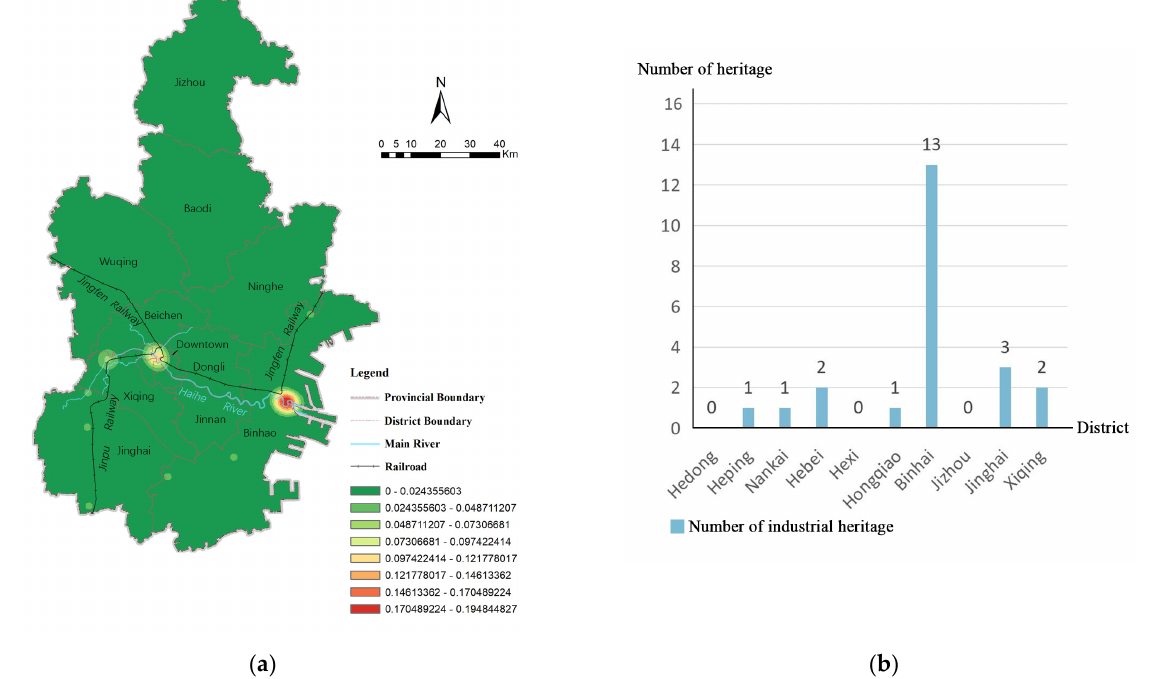
Figure 12. ( a ) Analysis of the kernel density of structure-type industrial heritage in Tianjin; ( b ) statistics on the total amount of structure-type industrial heritage in Tianjin by district.